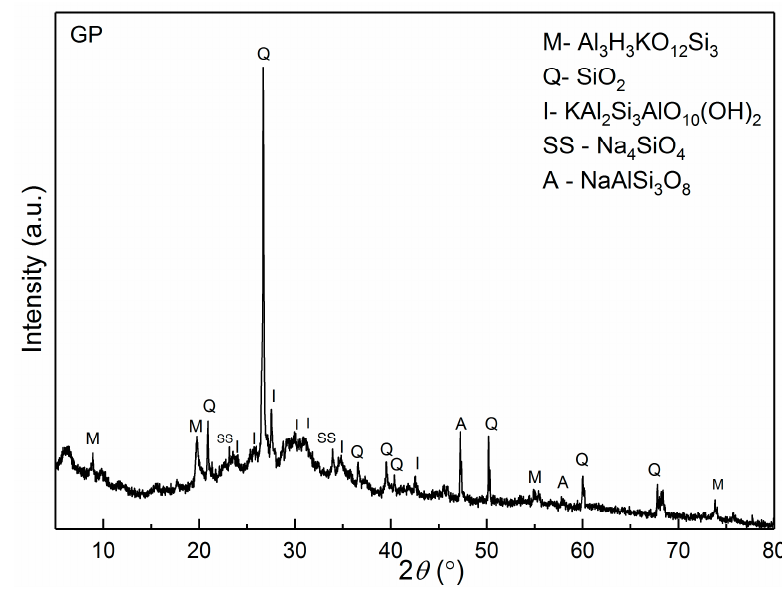
Figure 1. X-ray di ff raction pattern of pure geopolymer (GP) sample. Figure 1. X-ray diffraction pattern of pure geopolymer (GP) sample. Figure 1. X-ray diffraction pattern of pure geopolymer (GP) sample.